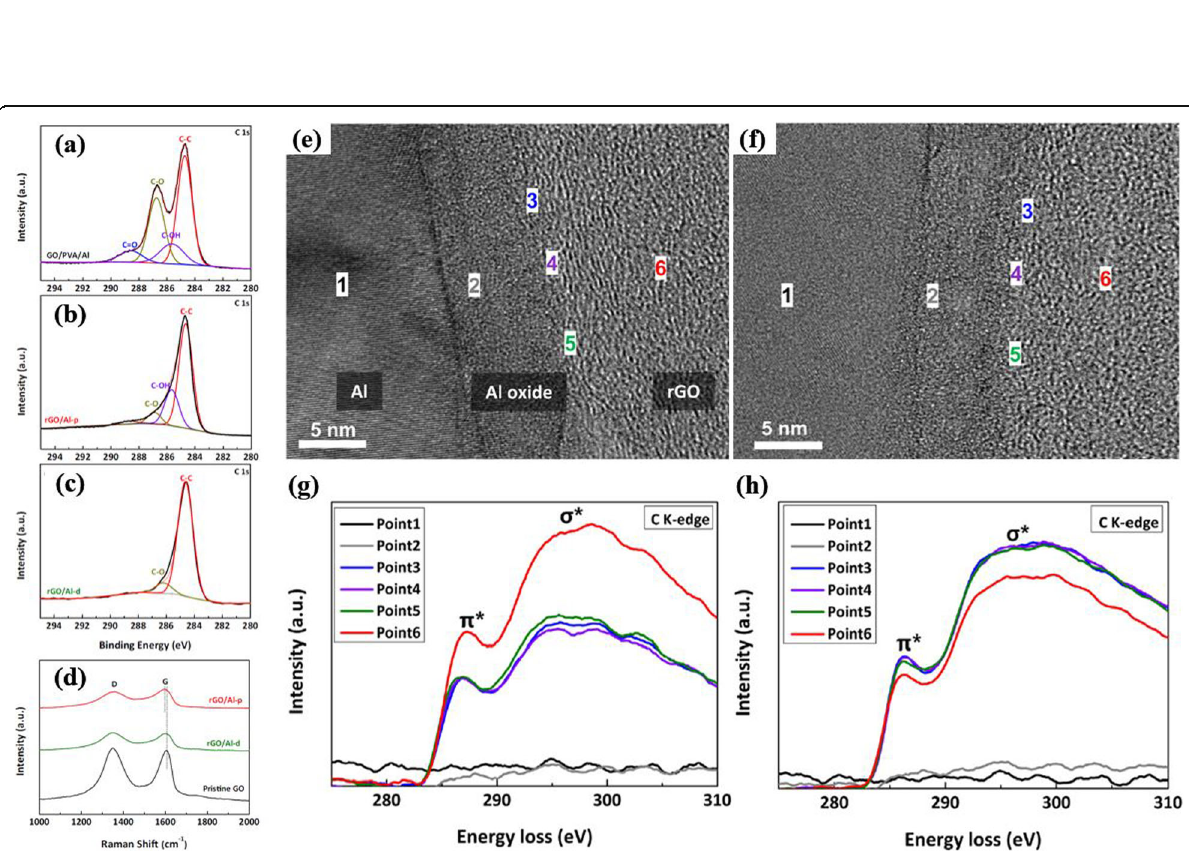
Fig. 8 XPS analysis of ( a ) GO/PVA/Al, ( b ) rGO/Al-p, ( c ) and rGO/Al-d hybrid materials together with ( d ) Raman spectra of pristine GO (black line), rGO/Al-d (green line) and rGO/Al-p (red line). ( e ), (f) HRTEM images of rGO/Al-p and rGO/Al-d together with ( g ), ( h ) their corresponding EELS spectra acquired from the marked points ‘ 1 – 6 ’ in ( e ) and ( f ) (Jang et al. 2017). Reprinted from Jang et al. (2017) ( Appl. Surf. Sci. 407, 1 – 7) with Applied Surface Science ’ s